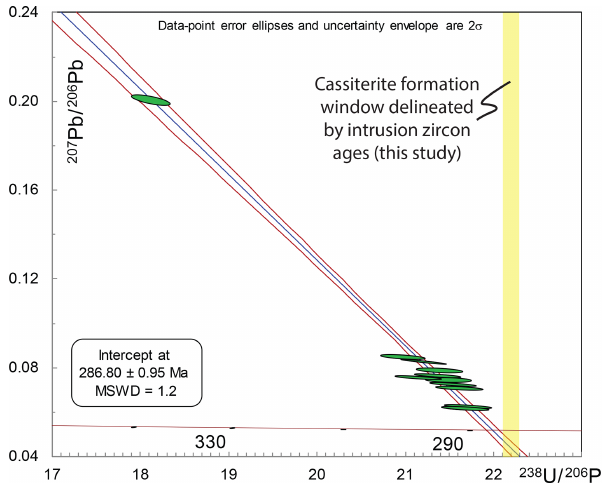
Figure 11. Illustration of how variable Pbc compositions in cassi- terite form a “single population”, yet with an inaccurate T–W lower intercept within lower single data-point precision datasets. The data are all HF-leached ID-TIMS U–Pb data from Cligga Head with ar- tificially expanded single data-point uncertainties of 1% (2 s ) for both 238 U / 206 Pb and 207 Pb / 206 Pb. This level of uncertainty is therefore a reasonable illustration of the upper range of analytical precision that may be achieved through microbeam techniques in relatively low-U-concentration materials such as cassiterite. Note that the data with artificial uncertainties do not show excess disper- sion (statistically acceptable MSWD) but produce a relatively pre- cise lower intercept (0.33%) outside the uncertainty and older than the maximum permitted age of cassiterite delineated by the granite (Fig. 6). This does not factor in any additional systematic or analyt- ical inaccuracy from lower-precision